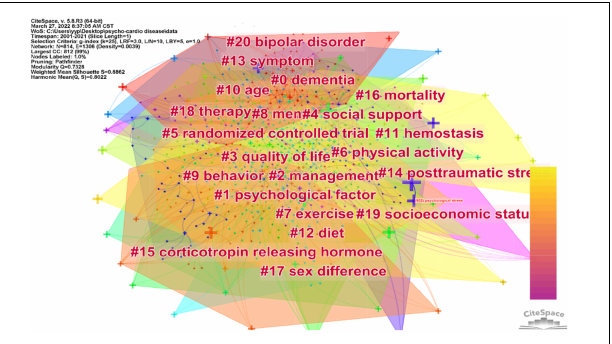
FIGURE 5 | Network of the keyword clusters in publications about the psycho-cardiological disease and related literature.